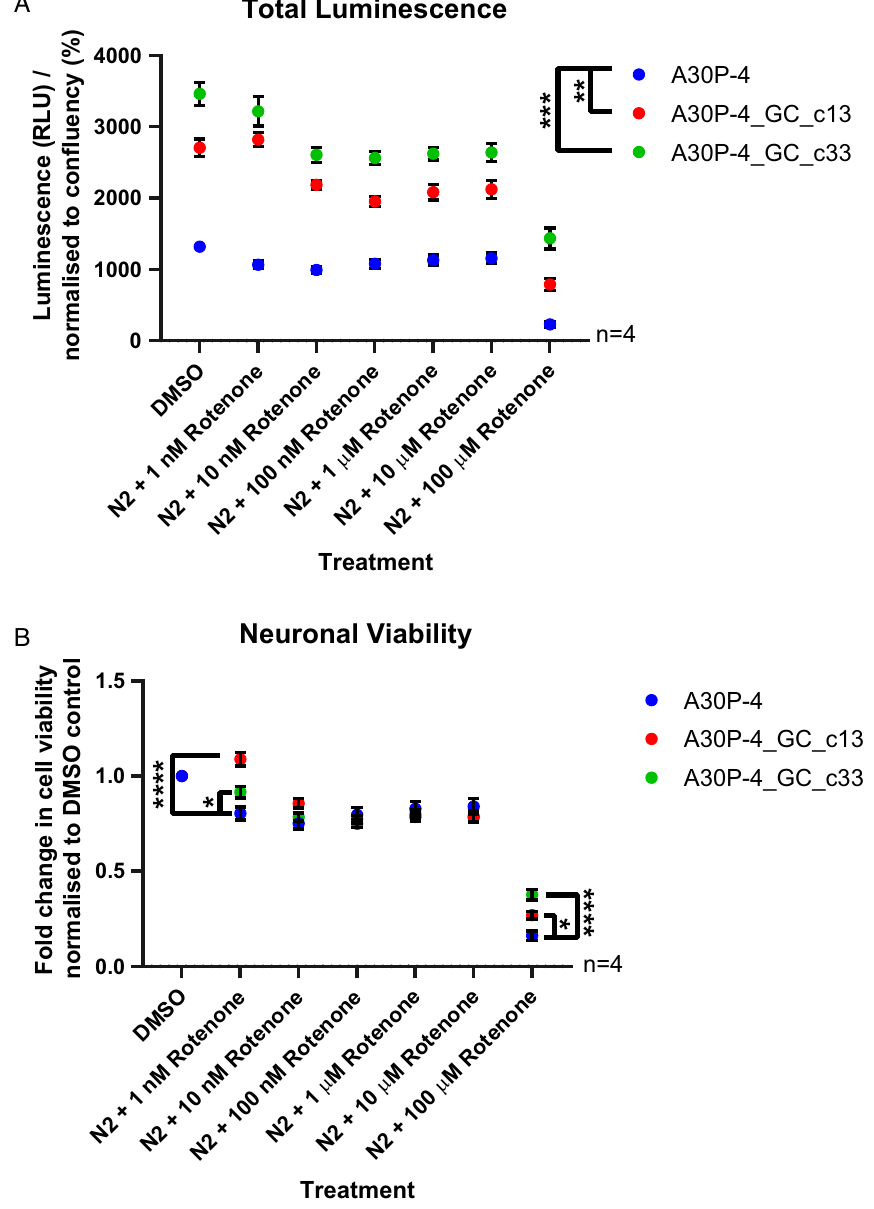
Figure 4. Neuronal viability after rotenone treatment. ( A ) Total luminescence profile of the patient-derived neurons using the CellTiter-Glo Luminescent Cell Viability Assay with increasing concentrations of rotenone treatment performed over 16 h. The neurons were differentiated for 40 days, a minimum of eight technical replicates were used per analysis with four biological replicates performed. For statistical analysis, an ordinary one-way ANOVA was performed using the Tukey post-hoc multiple comparison test. ( B ) Fold change in cell viability of patient-derived neurons normalised to DMSO control. A two-way ANOVA was used with a Turkey’s post-hoc multiple-comparison test. All graphs were plotted as mean ± SEM. *p < 0.05, **p < 0.01, ***p < 0.001 ****p <